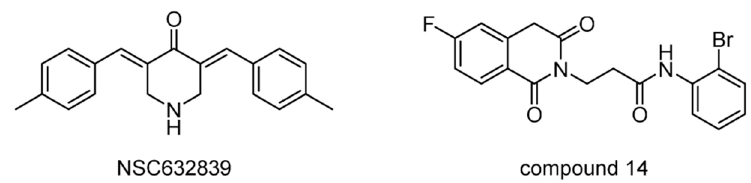
Figure 10. Structures of reported USP2/7 inhibitors.